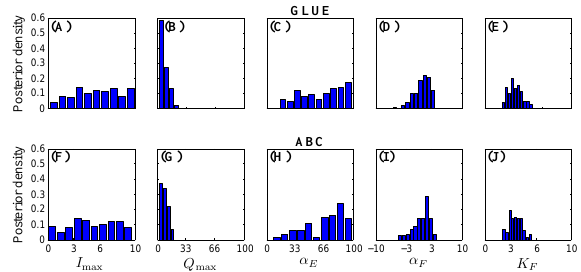
Fig. 9. Posterior distribution of five randomly selected hmodel parameters derived from the French Broad calibration data set: (A) I max , (B) Q max , (C) α E , (D) α F , and (E) K F